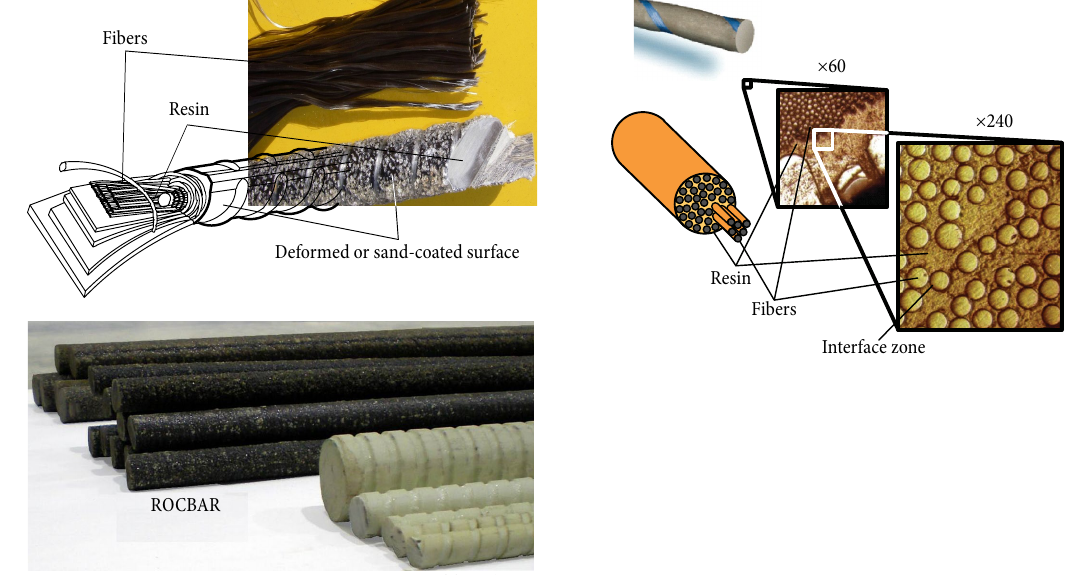
Fig. 1. The structure and coating of FRP bars